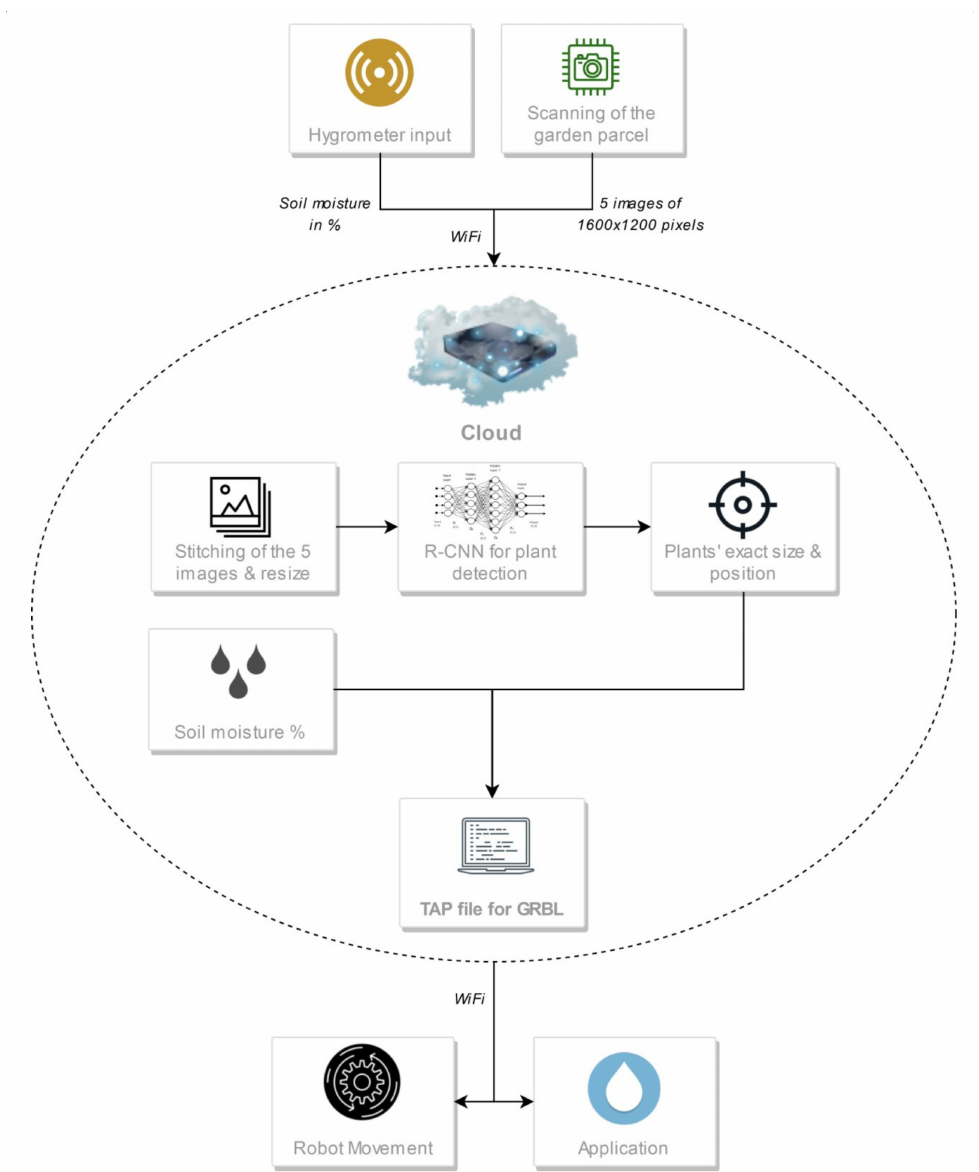
Figure 10. Flow chart of CityVeg overall system